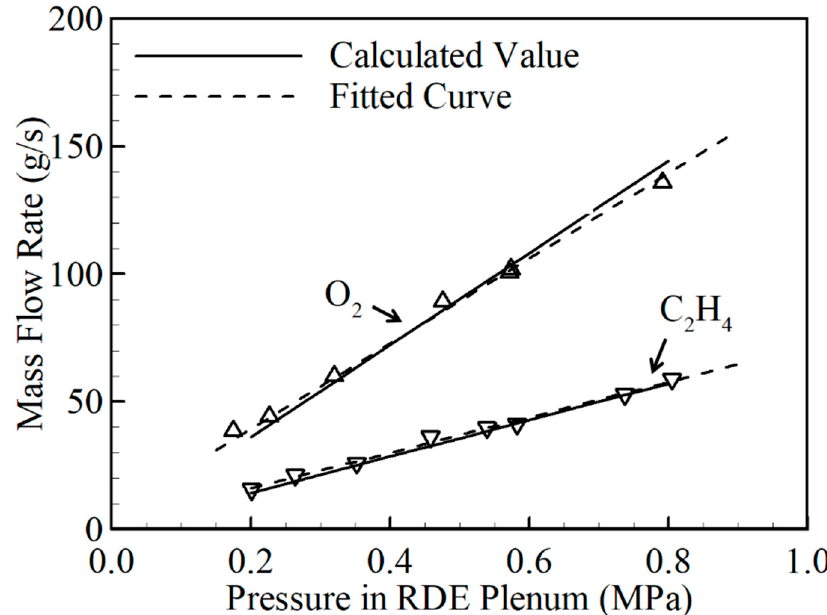
Figure 5. Comparison of measured and calculated mass flow rates.